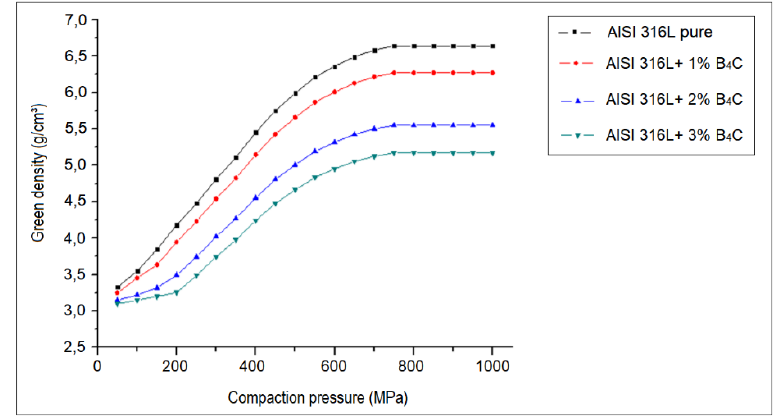
Fig. 5. Compressibility curves of 316L with B 4 C powders.